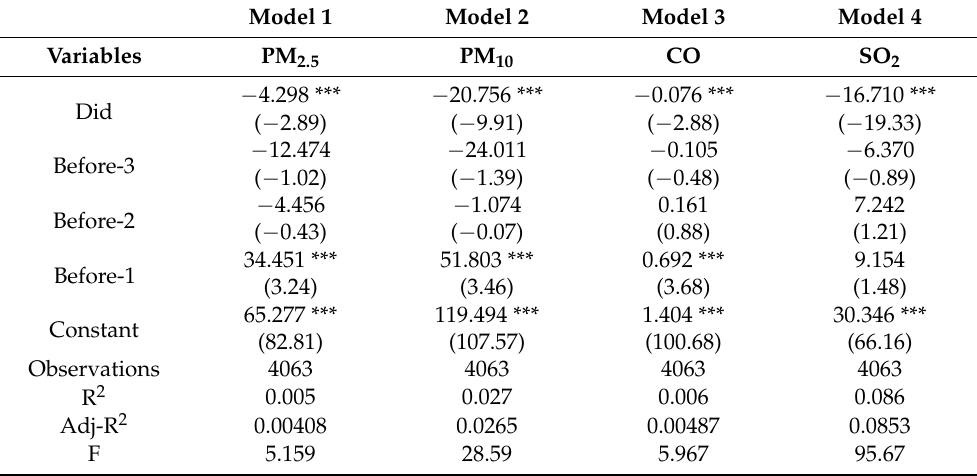
Table 8. Parallel trend test